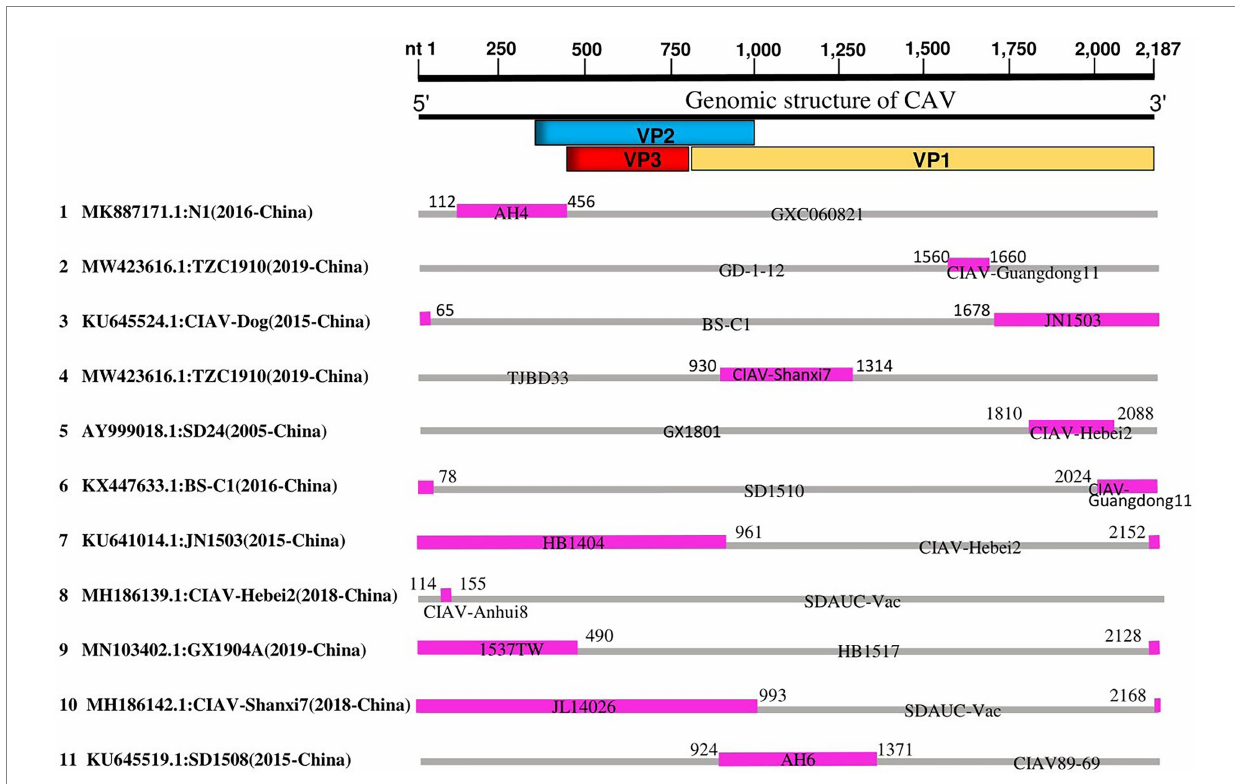
FIGURE 4 Genetic recombination analysis of 243 full-length genomes of CAV, 1991–2020. Diagram on the top showing the full-length genome of CAV and the corresponding regions encoding the VP1, VP2, and VP3 proteins. The numbers indicate the nucleotide positions relative to the genome of CAV. Schematic representation of the eleven potential recombination events listed in Table 2. The serial number of the recombination events and the description of potential recombinants (GenBank ID: virus name/collection year-country/region) are shown on the left. The pink and gray blocks represent the DNA regions from minor and major parent viruses, respectively. The numbers on the top of filled pink blocks indicate the nucleotide positions of breakpoints relative to the genome sequences of the corresponding recombinant viruses on the